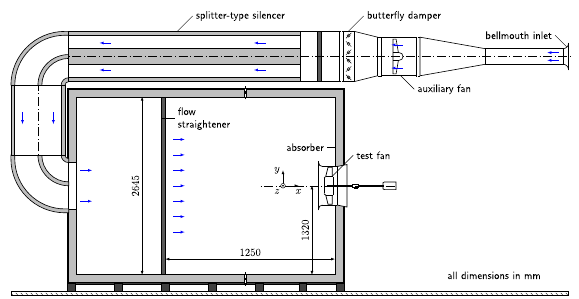
Figure 1. Measurement locations for the evaluation of the fl ow results. Velocity measurement planes in green and the positions of four selected transducers in black.